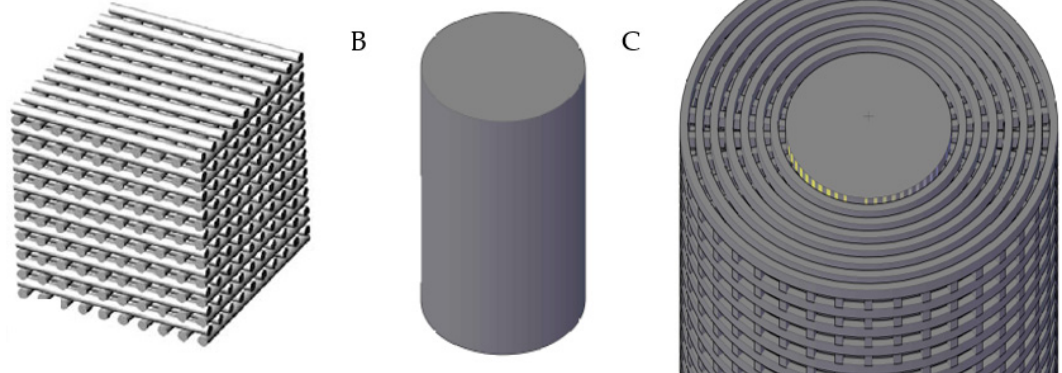
Figure 1. Schematic illustration of the 3D CAD designs for robocasting; lattice ( A ), dense ( B ) and bi-layer ( C ) models.